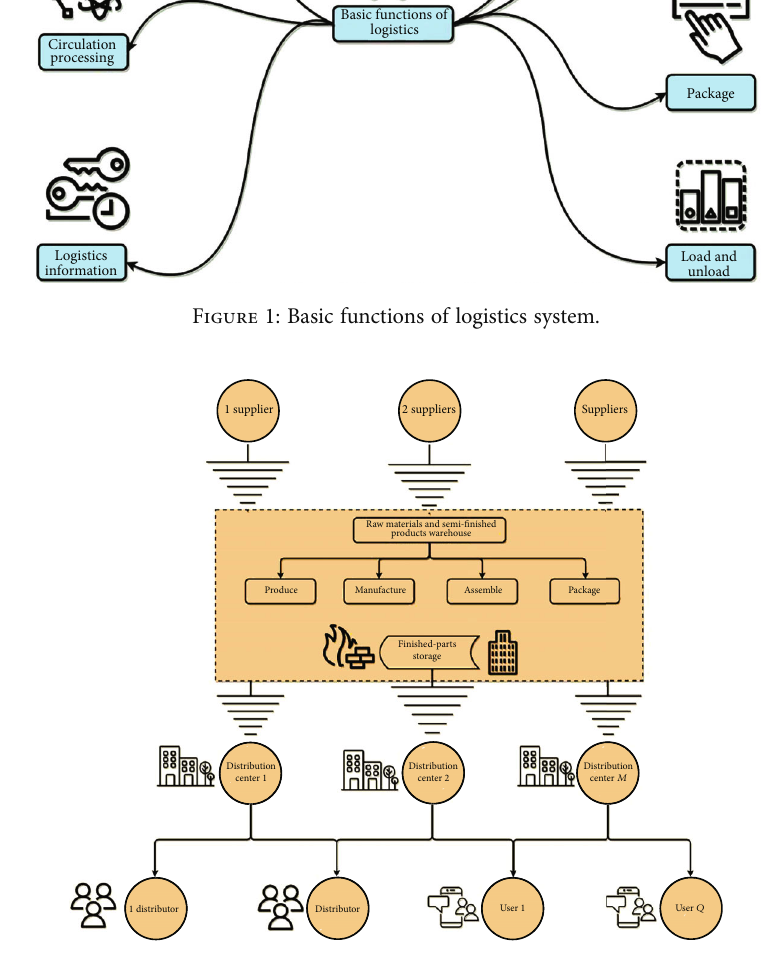
Figure 2: Supply chain logistics system